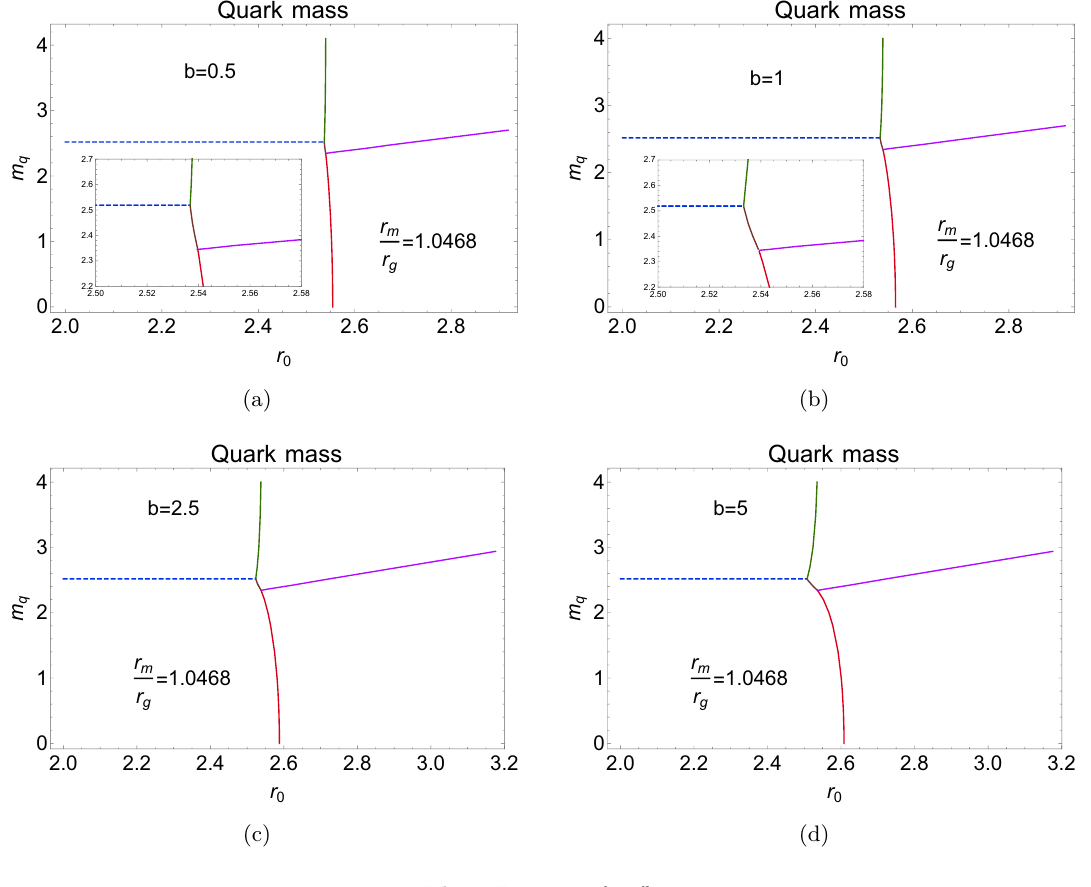
Figure 9 . Phase Diagram for r m